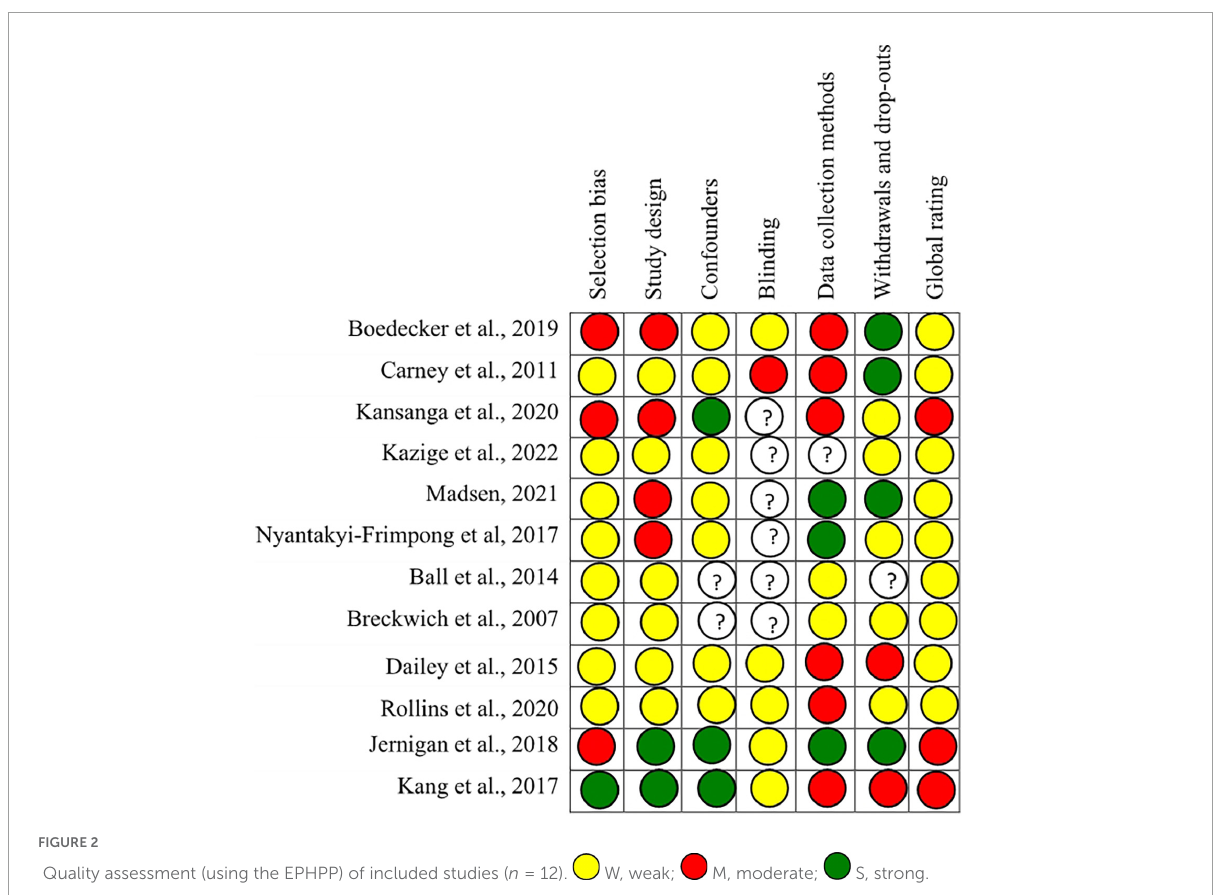
FIGURE2 Quality assessment (using the EPHPP) of included studies ( n = 12). W, weak; M, moderate; S,